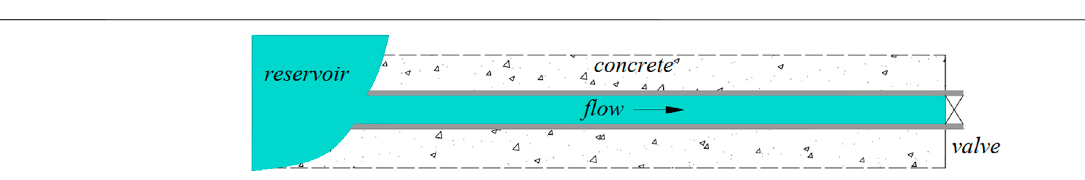
FIGURE 5 | Side view of water conveyance system encased in concrete.